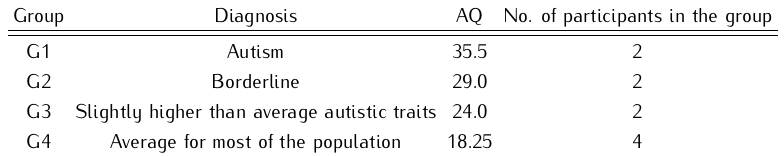
Table 1. Four groups of participants